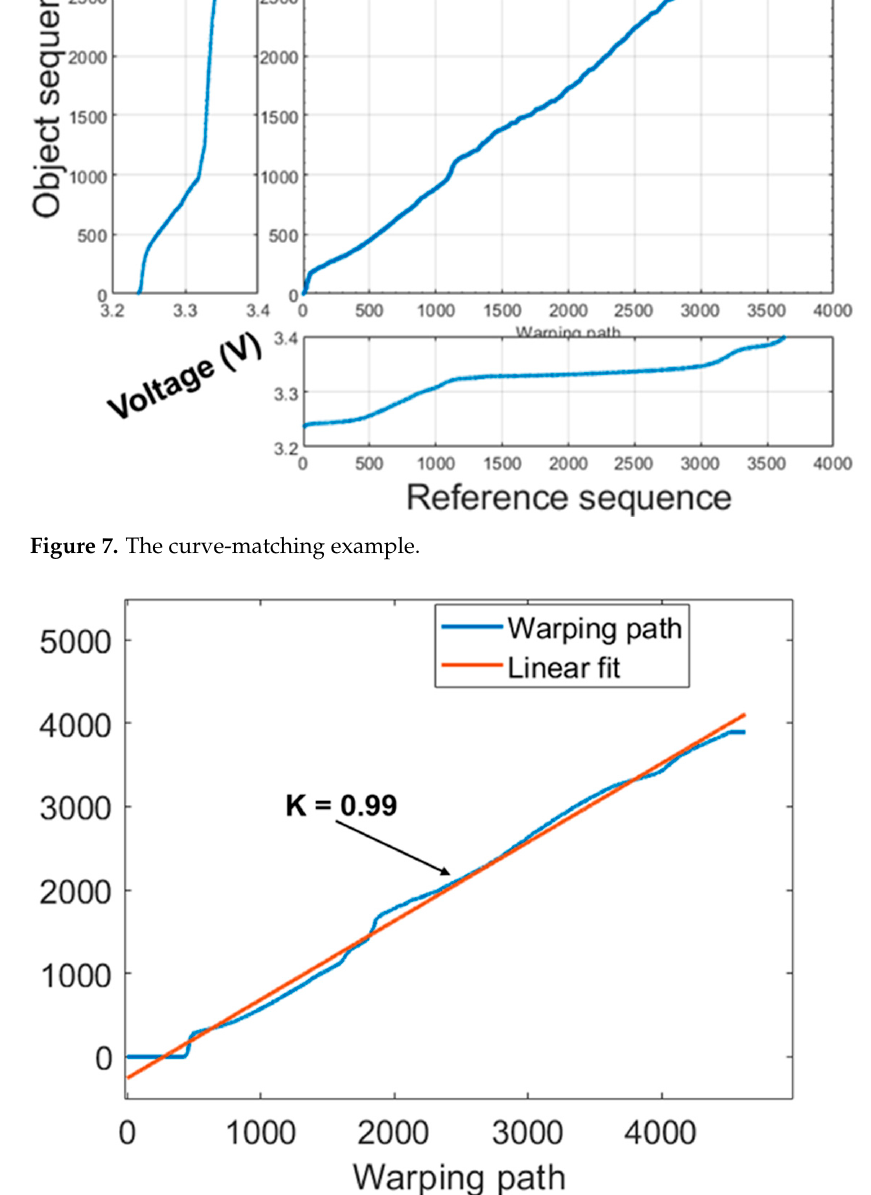
Figure 7. The curve-matching example.